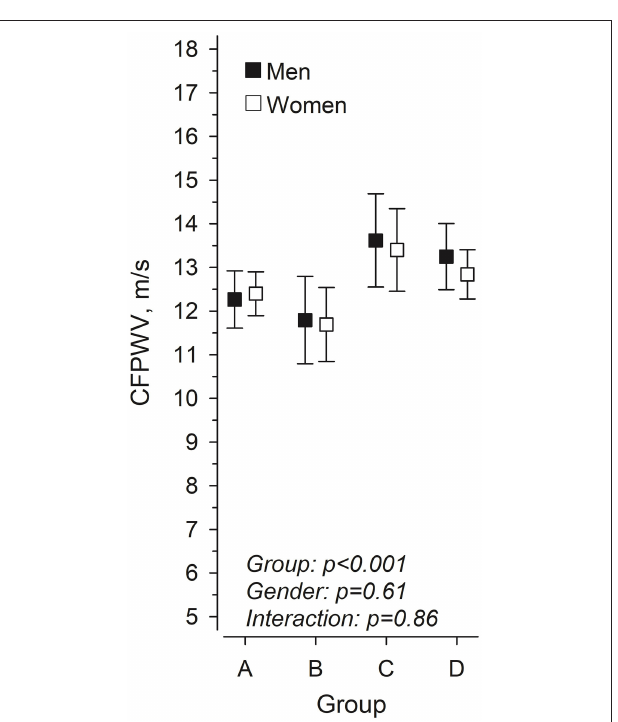
FIGURE 2 | Pulse wave velocity in women and men at mean age 76 years according to body composition at 61 years, in four groups based on lean mass index (LMI) and fat mass index (FMI). (A) low LMI and low FMI, (B) high LMI and low FMI, (C) low LMI and high FMI, and (D) high LMI and high